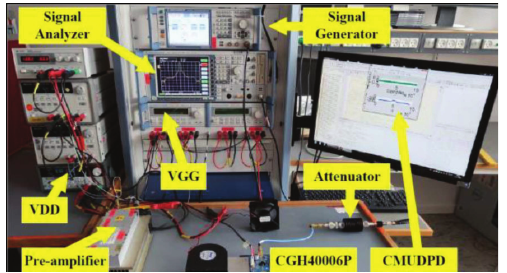
Figure 12. Experiment setup.